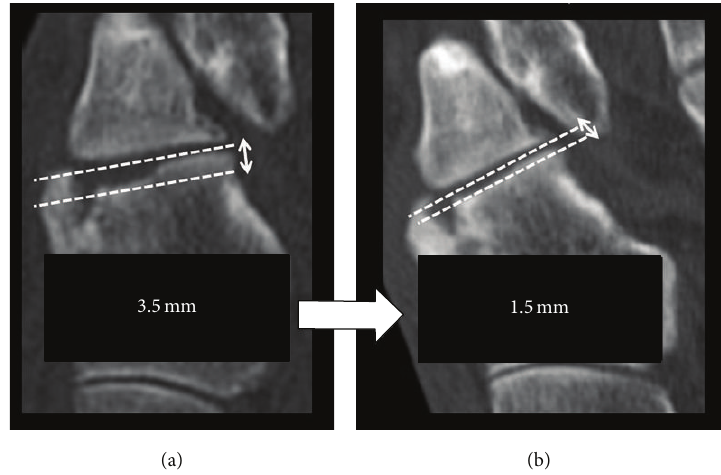
Figure 8: Depression of the cuboid articular surface: (a) prior to surgery; (b) 6 months after